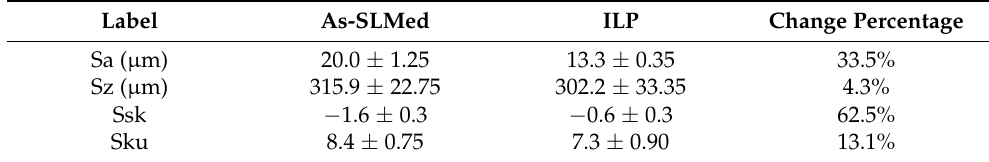
Table 1. Average value of surface